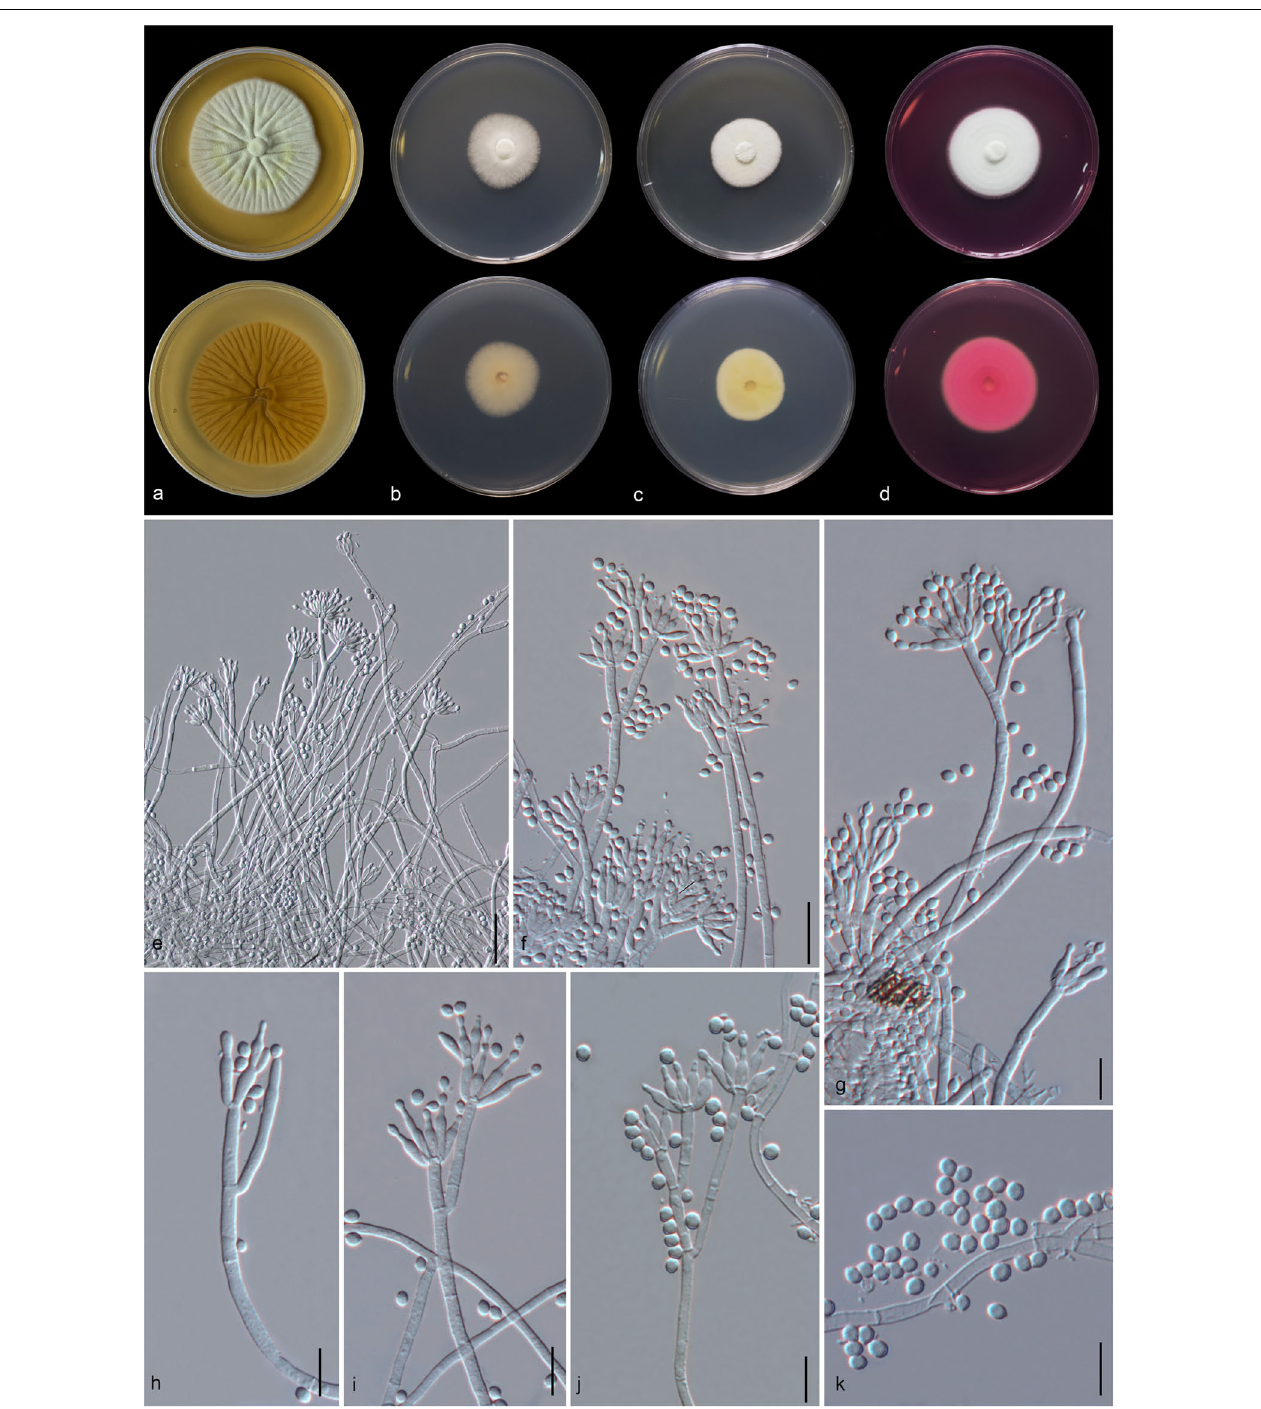
FIGURE 10 | Penicillium guaibinense (MFLU 20-0433). (a–d) Colonies on MEA, CYA, PDA and rosebengal at 25 ◦ C, respectively. (e–j) Conidiophores and conidia. (k) Conidia. Scale bars: (e,f) = 20 µ m, (g–k) = 10 µ m.